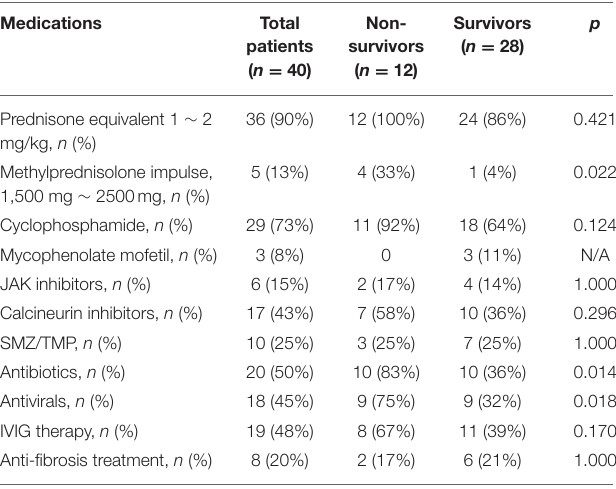
TABLE 2 | The medications for patients with anti-MDA5-positive DM during the 6-month follow-up. Medications